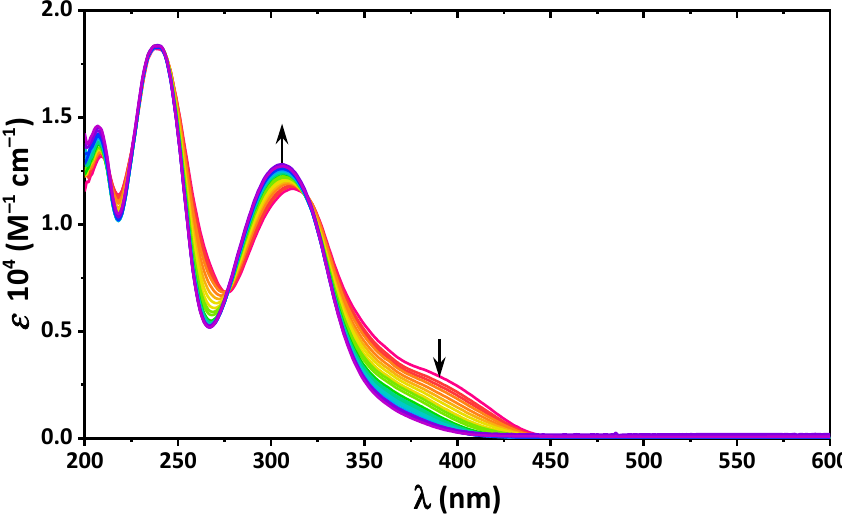
Figure 5. UV-vis spectra of 4 in EtOH upon gradual addition of CH 3 SO 3 H up to 2 eqv., with a step of 0.1 eqv.